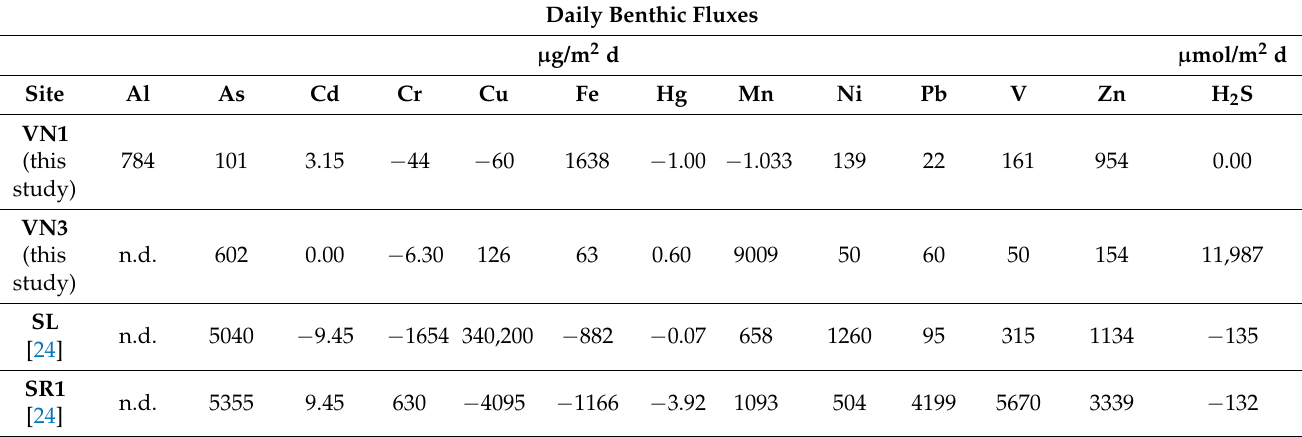
Table 4. Comparison among benthic fluxes of metal(loid)s and H 2 S [12] estimated at VN1 and VN3 and those re-calculated in two marinas (SL, Lucija Marina (SLO), and SR1, San Rocco Marina (ITA), [23]), using the same method used in this study [27]. The abbreviation “n.d.” indicates “not